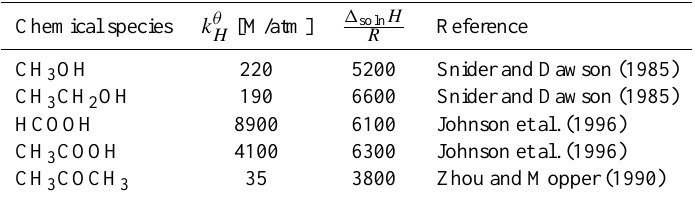
Table A3. Details concerning the chemical data that is used for the calculation of heterogeneous scavenging rates for the additional soluble organic species that are included in the modified CB05 chemical mechanism. Here k θ is the enthalpy of solution and R the gas constant. For the inorganic species and other organic species the reader is referred to Huijnen et al.